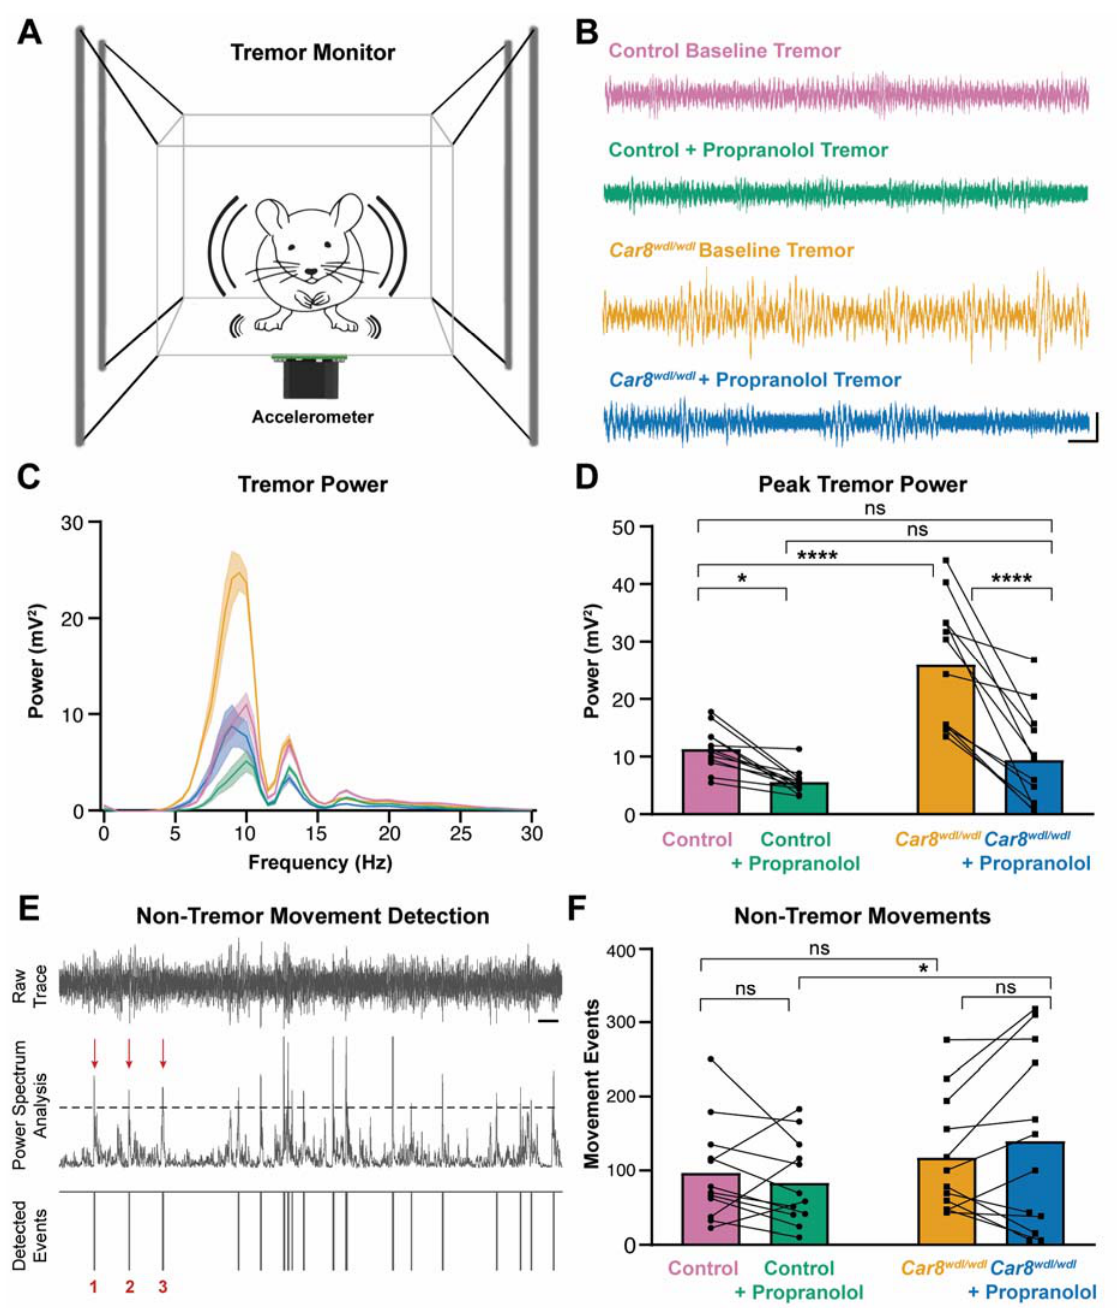
Figure 1. Propranolol reduces pathological tremor in Car8 wdl/wdl mice and physiological tremor in control mice. ( A ) Schematic of the tremor monitor configuration. ( B ) Representative raw traces of tremor readings recorded from the tremor monitor for control mice at baseline (pink, N = 12), control mice after propranolol treatment (green, N = 12), Car8 wdl/wdl mice at baseline (orange, N = 12), and Car8 wdl/wdl mice after propranolol treatment (blue, N = 12). Larger vertical deflections indicate stronger tremor power. Scale bar is 50 mV vertical and 500 ms horizontal. ( C ) Line graph depicting tremor power versus frequency. Color representation for groups is maintained from panel B. Power indicates the presence and severity level of tremor, with higher power illustrating stronger severity. Frequency indicates the speed of tremor movements. Following propranolol treatment, both control and Car8 wdl/wdl mice exhibit reduced tremor power compared to baseline. ( D ) Bar graph showing quantifications of peak tremor power at baseline and after propranolol treatment in control and